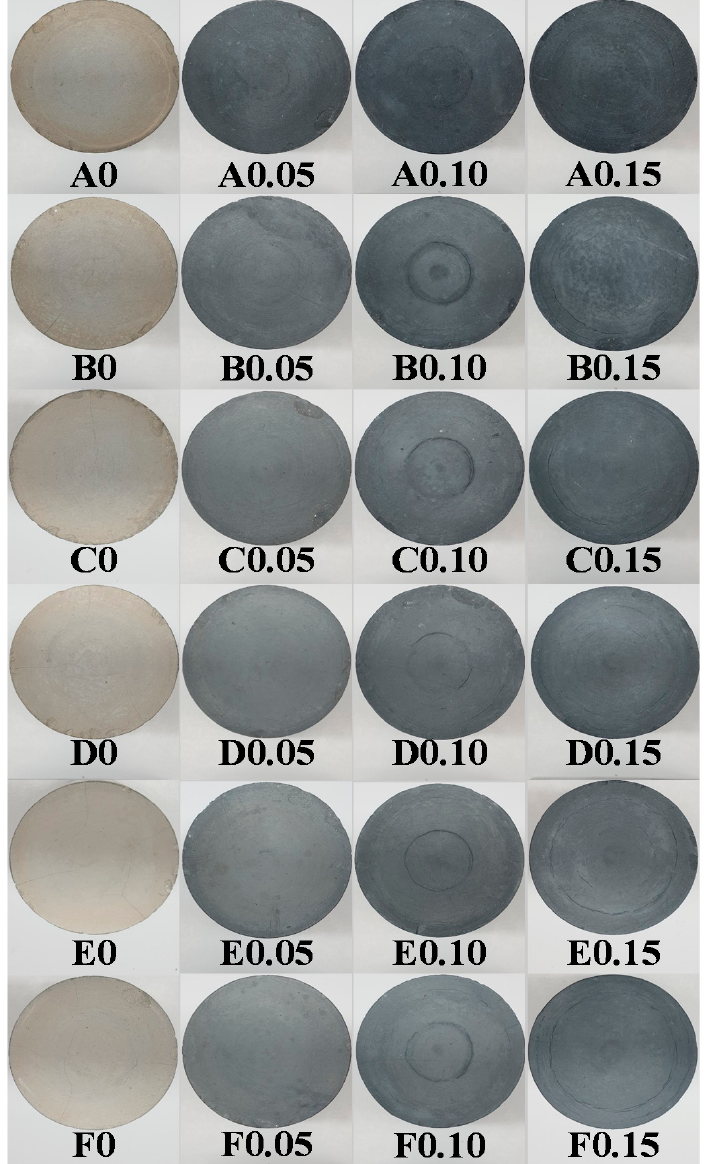
Figure 2. Surfaces of the cured specimens for